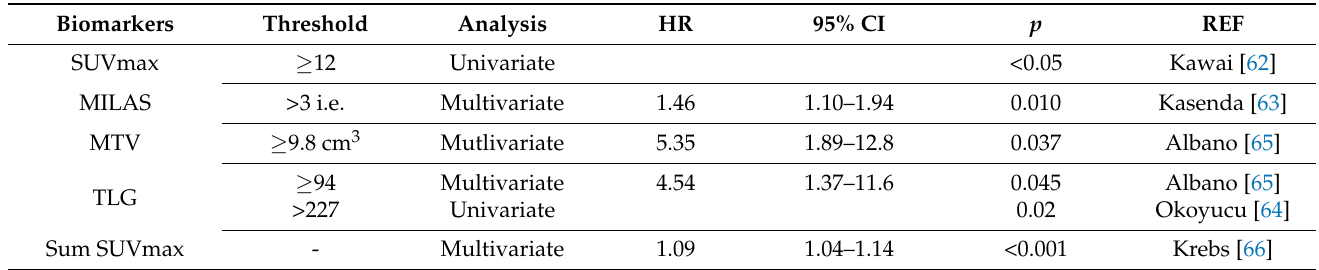
Table 2. 18 F-FDG PET Biomarkers of poor